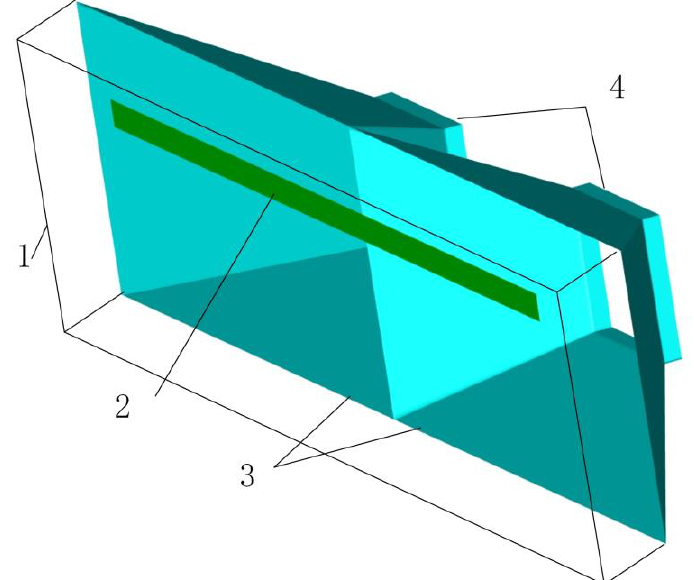
Figure 6. Fluid domain model of the wind-collecting hood. Note: 1 — External area of the wind-collecting hood; 2 — Particle inlet; 3 — Suction film port of the wind-collecting hood; 4 — Outlet.